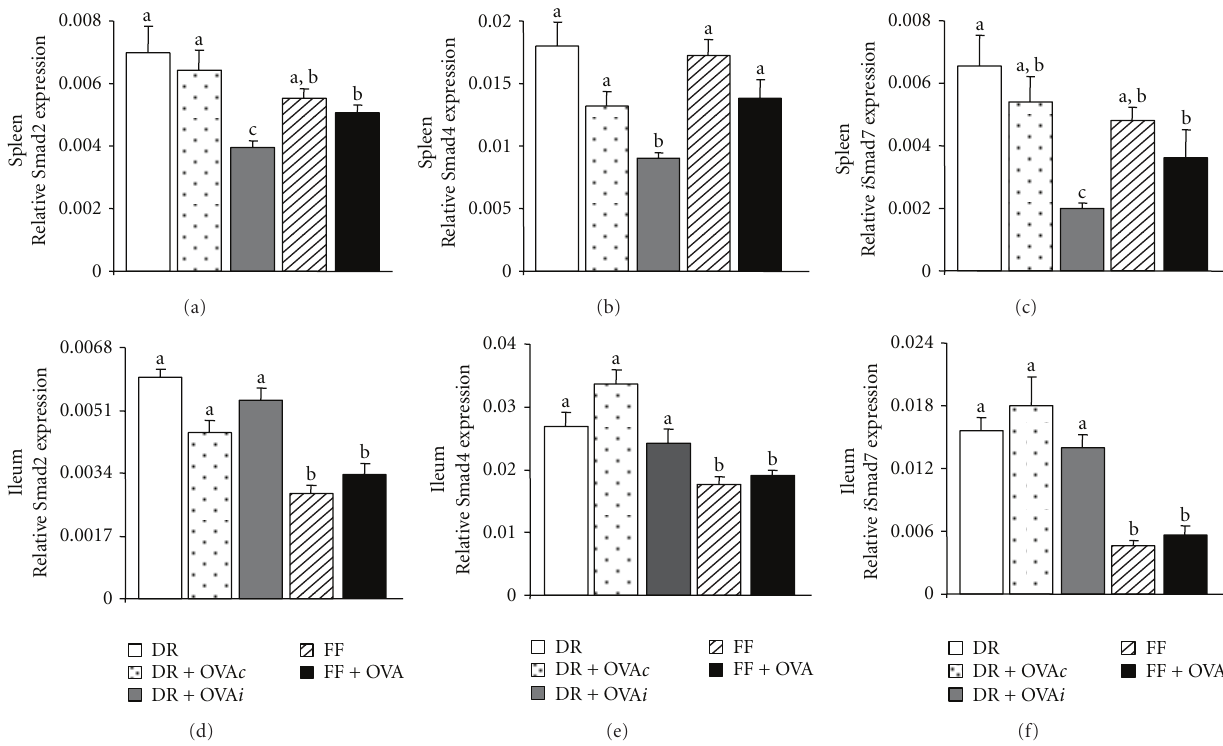
Figure 3: Splenic and ileal mRNA expression of Smad pathway genes in DR and FF pups at day 14 with or without daily/intermittent treatment with OVA. Smad2, 4, and 7 mRNA levels in spleen (a, b, and c) and Smad2, 4 and 7mRNA levels in ileum (d, e, and f) as determined by real-time PCR. Bars are mean + SEM, n = 7-8. Means without a common letter di ff er, P < 0 .